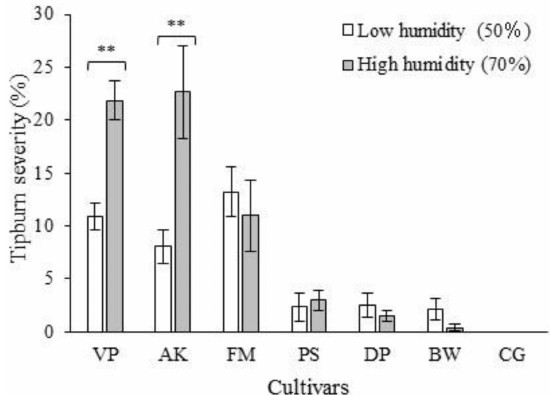
Figure 1. Mean tipburn severity in seven lisianthus cultivars (VP: “Voyage pink”, AK: “Azuma-no-kaori”, FM: “Fuyu-no-maria”, PS: “Piccolosa snow”, DP: “Diamond peach”, BW: “Bolero white”, and CG: “Celeb green”) under low and high air humidity treatments. Cultivars are arranged in order of mean tipburn severity for the low and high humidity treatments. Error bars represent SE (Standard Error; n = 12). * Represents significant differences between results for the low and high humidity treatments (Student’s t -test: ** p < 0.01).